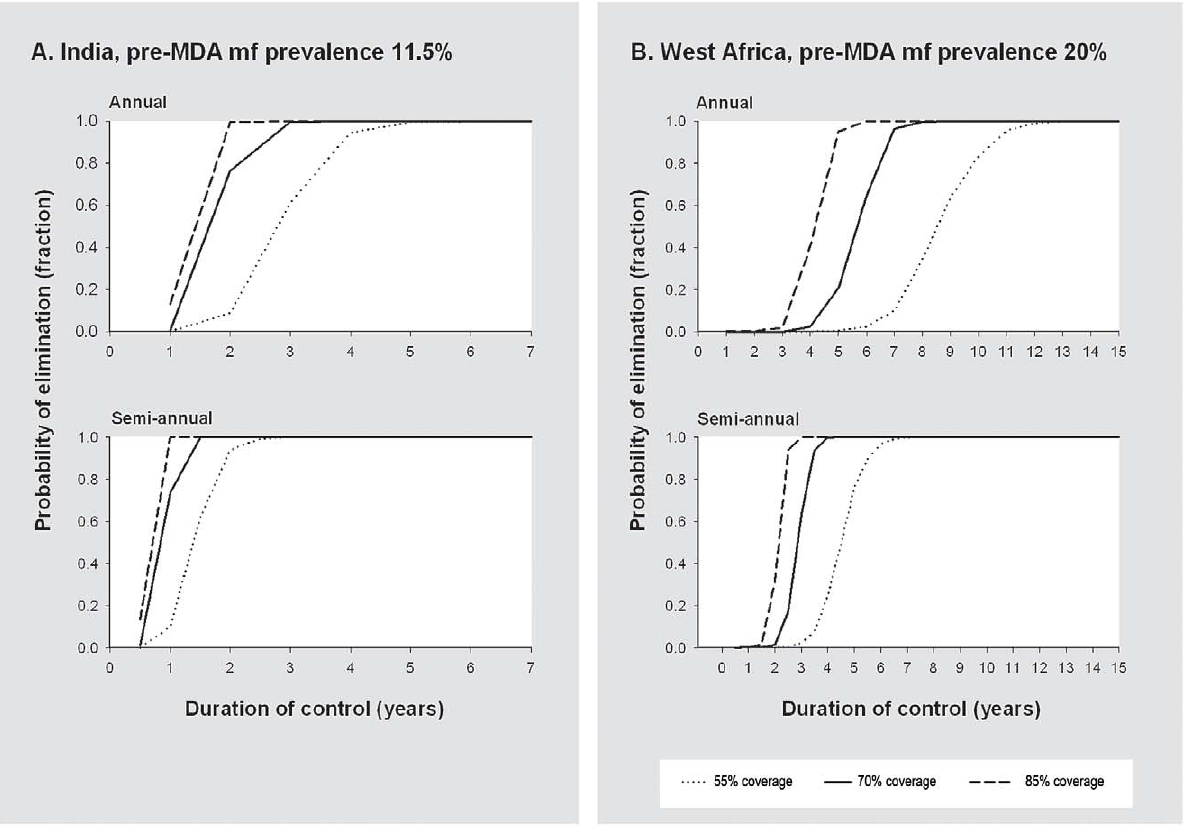
Figure 2. Probability of elimination in relation to the duration of mass drug administration. Panel A shows the results for an Indian setting with a pre-control mf prevalence of about 11.5%, for annual and semiannual mass drug administration and for different coverage levels (percentage of the total population that is treated per round). Similarly, panel B shows the results for an African setting with a pre-control mf prevalence of about 20%. The indicated mf prevalence levels are for diagnosis with 60 m L night blood